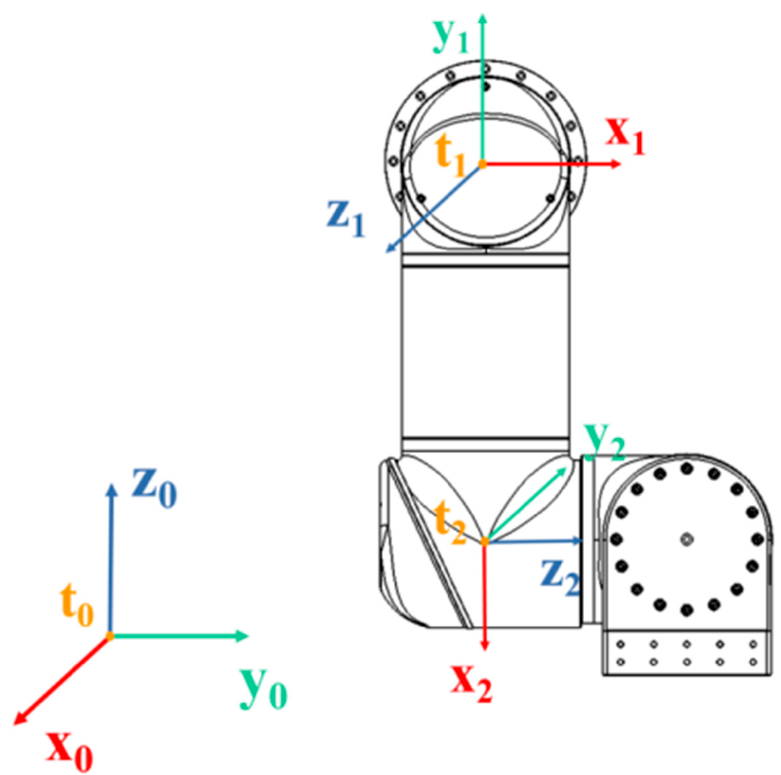
Figure 4. Front view of T 0 and RF joint coordinate system RF-T 1 , RF-T 2 .